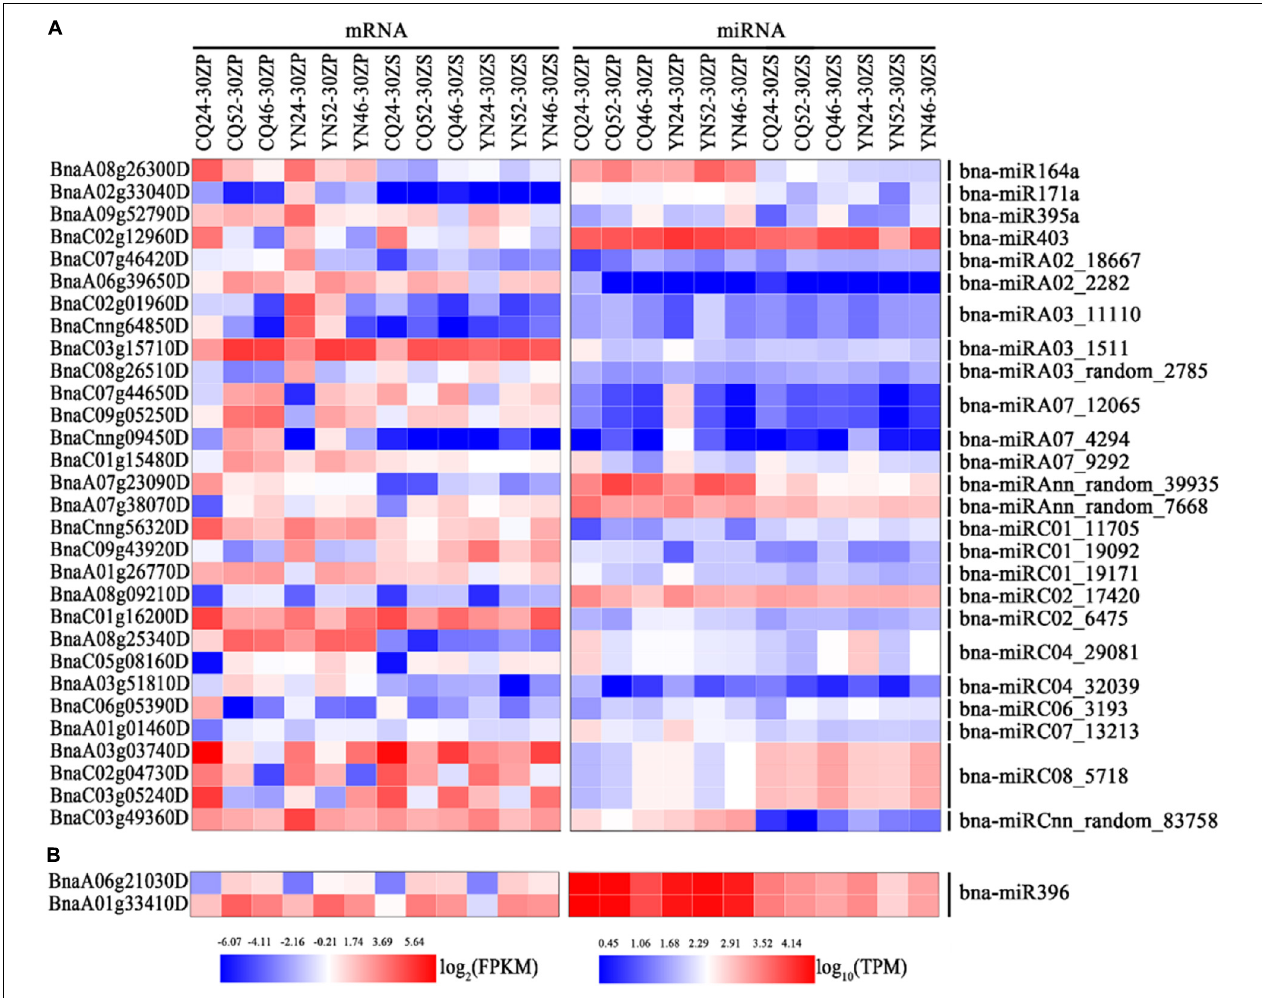
FIGURE 4 | Heatmap representation of interesting miRNA-mRNA pairs identified in silique pericarps and seeds. (A) Heatmap representation of miRNA-mRNA pairs-related circadian rhythm, response to stress, response to abiotic stimulus, and response to stimulus in silique pericarps. (B) Heatmap representation of bna -miR396-modulated miRNA-mRNA pairs in seeds. The color bars under the figures represent log 2